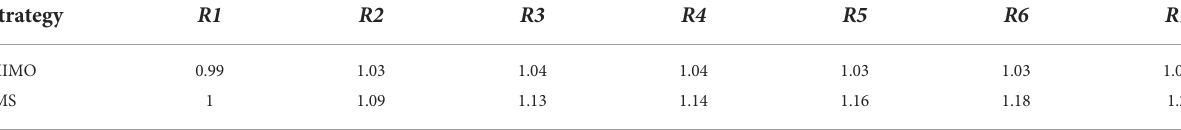
TABLE 1 The prediction performance of MIMO and IMS strategy for each step.